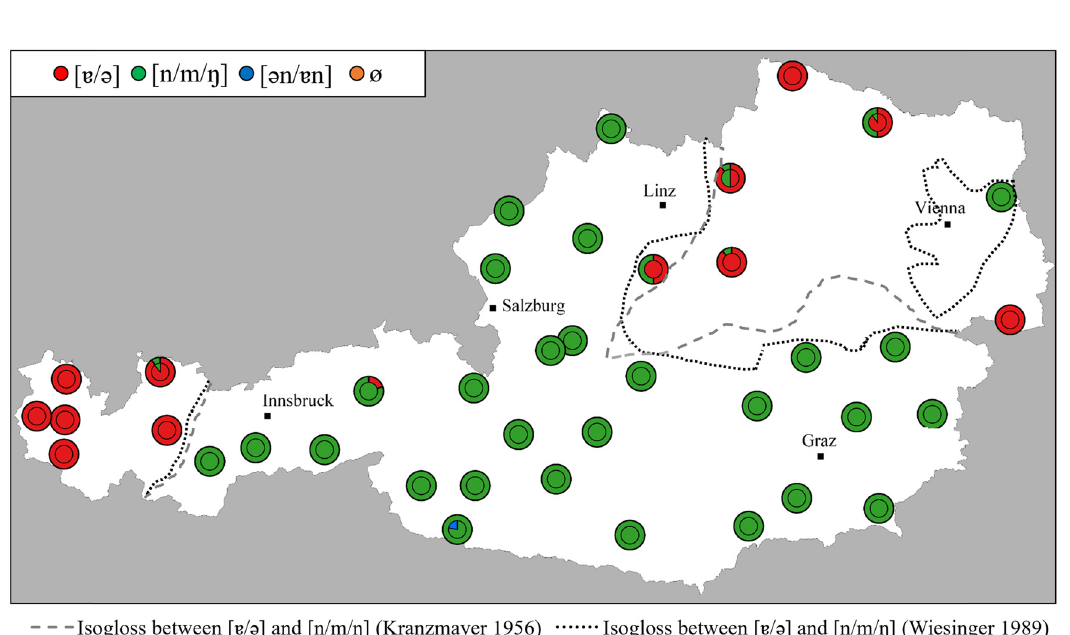
Figure 5: ( en ) following labiodental fricatives ( inner circles = percentage of variants realised by older speakers; outer circles = percentage of variants realised by younger speakers )